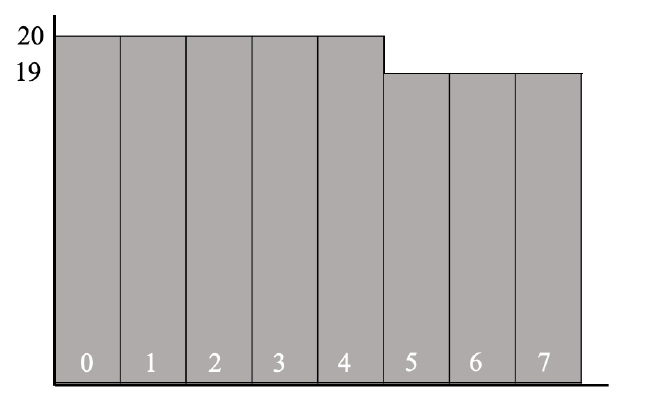
Figure 6. Labelled histogram